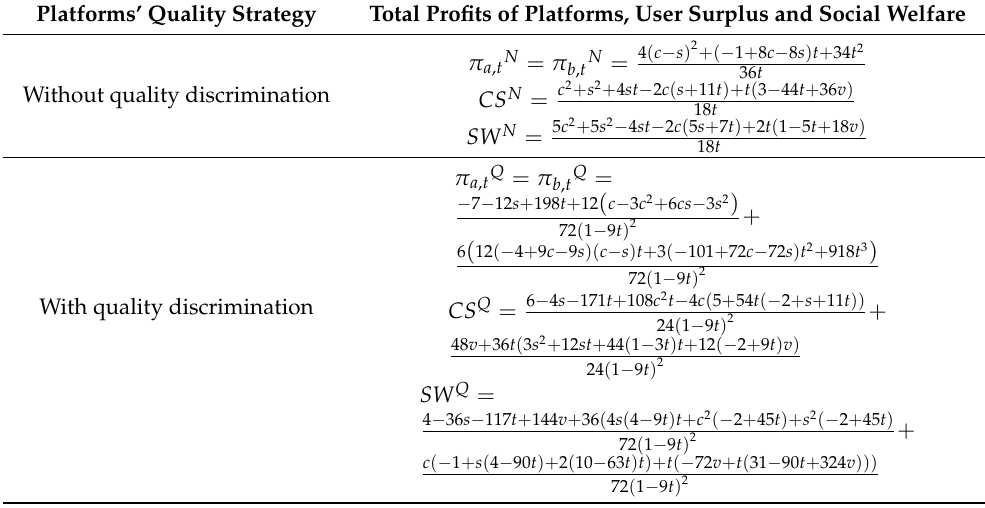
Table 3. Total platforms’ profit, user surplus, and social welfare in equilibrium. Platforms’ Quality